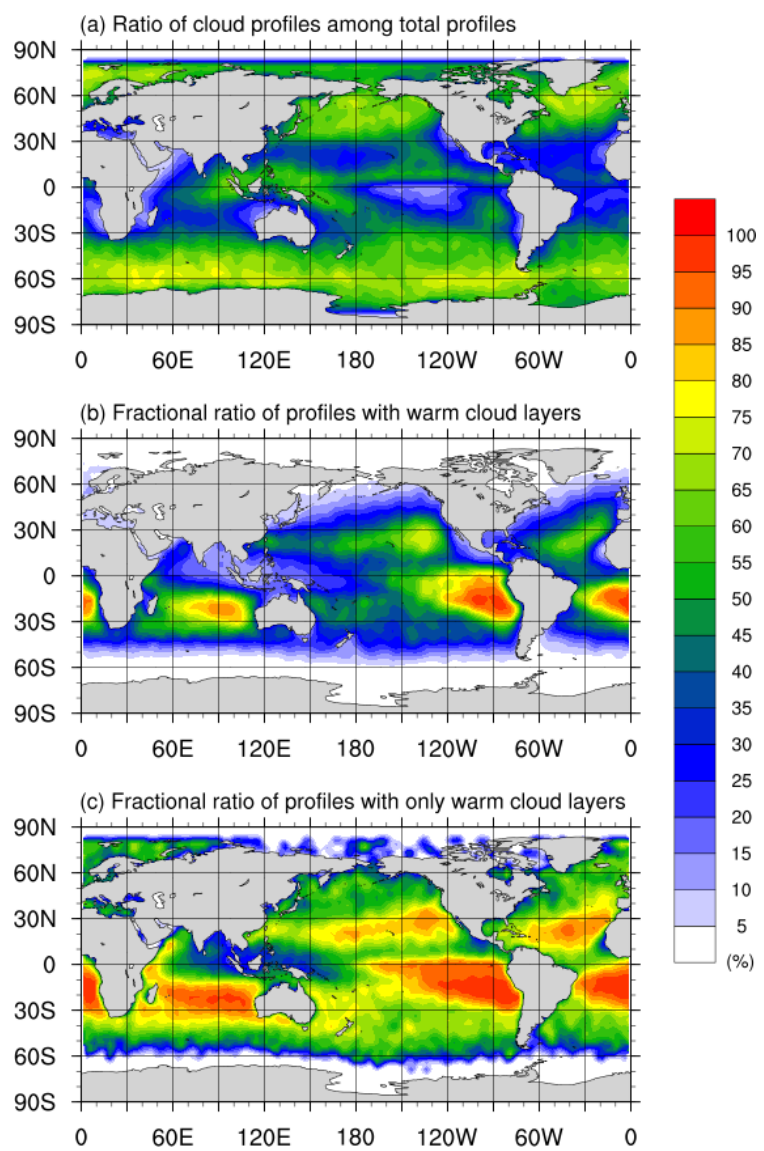
Figure 2. Ratio of cloud profiles among total profiles ( a ), ratio of profiles with warm cloud layers among cloud profiles ( b ), and ratio of profiles with only warm cloud layers among those with warm cloud layers ( c ), in each 2.5° × 2.5° grid over global oceans.